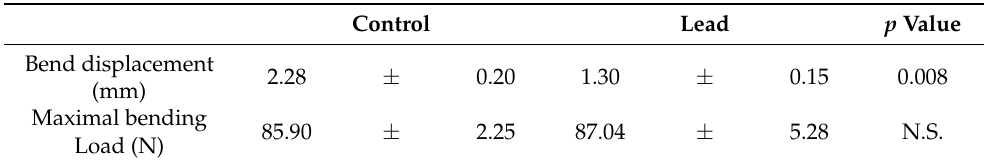
Table 2. Three-point bending test in rat mandibles in the chronic lead exposure ( n = 8) and control ( n = 5) groups. Values are expressed as means ± S.E.M. (N.S. = not significant).